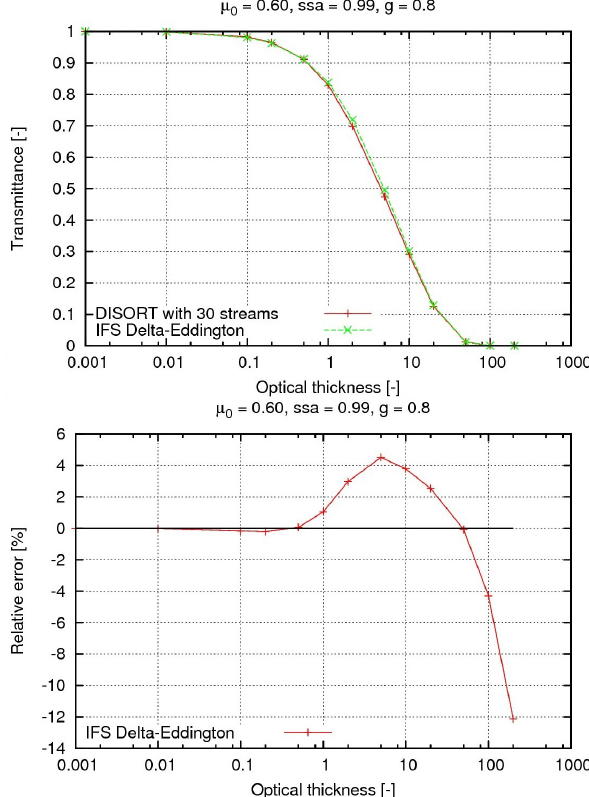
Figure 29. The results in this figure are calculated for an asymmetry factor g = 0 . 8 and a cosine solar zenith angle µ 0 =0.60. The upper plot shows comparison of DISORT and IFS transmittances for a single scattering albedo of 0.99 as a function of optical thickness τ . The lower plot shows the corresponding relative